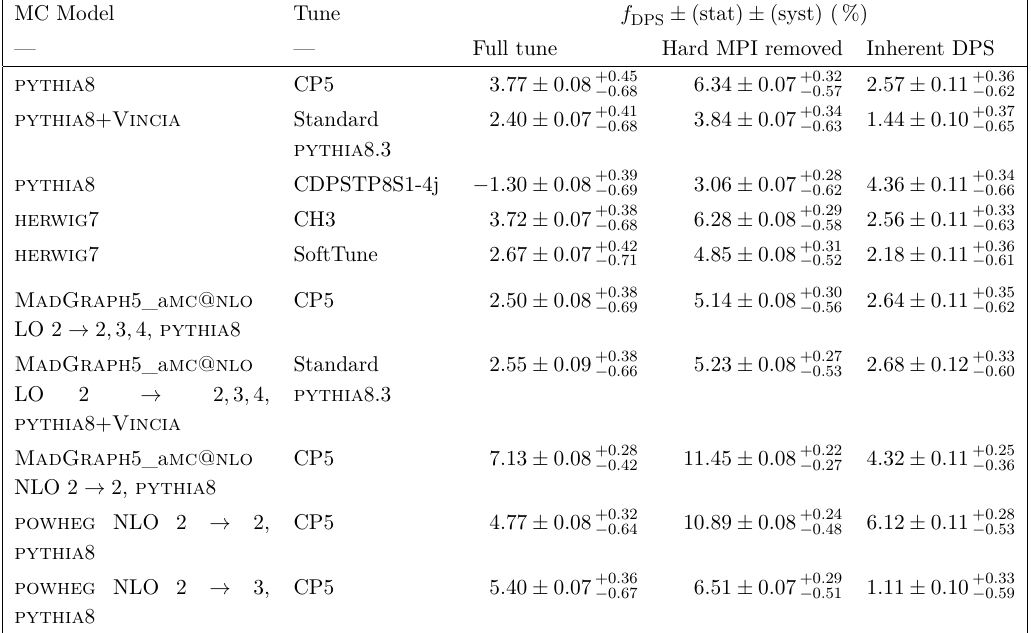
extracted from data using different SPS models, Table 6 . The values of the DPS fraction f DPS along with their statistical and systematic uncertainties. The results are shown for the model where the full tune is used, and for the same models where the hard MPI have been removed. The last column shows the net difference between the two first columns, and is interpreted as the fraction of DPS inherent to the